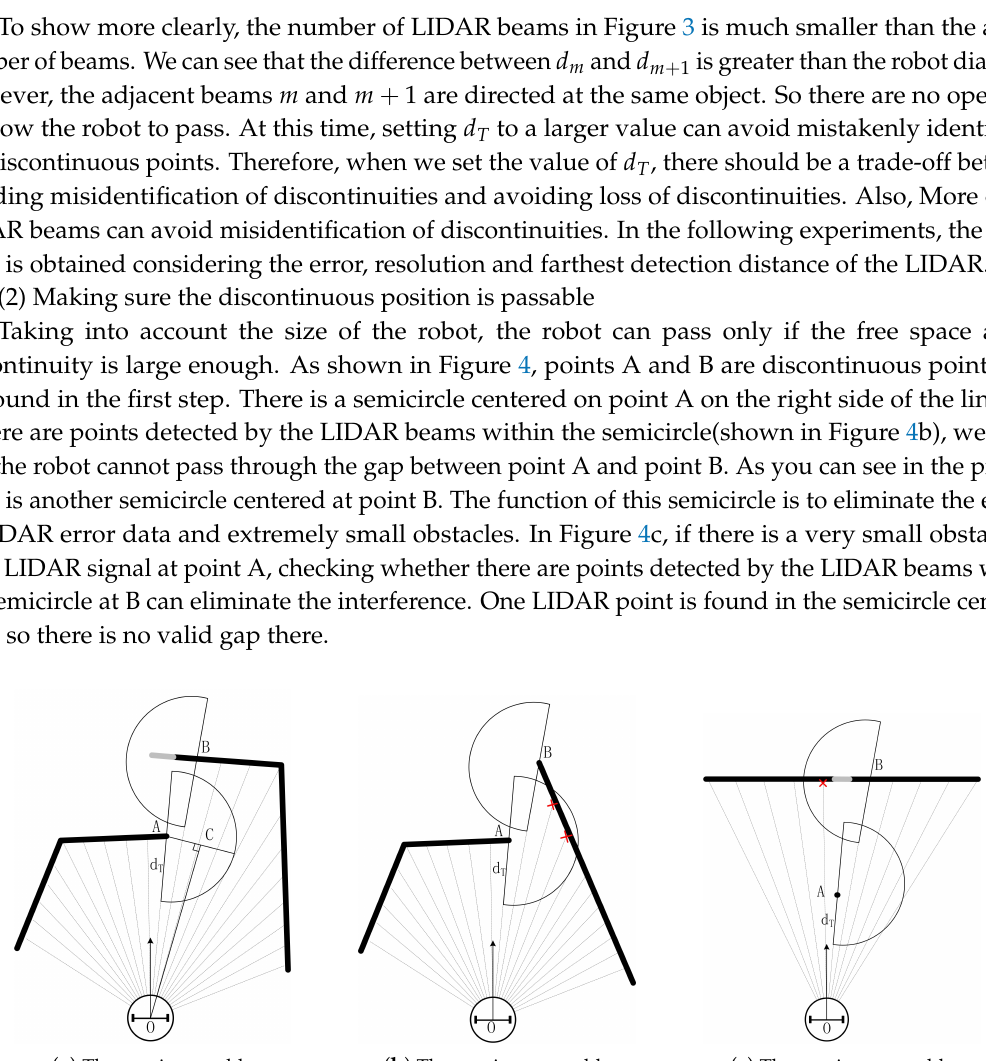
Figure 3. Representation of the LIDAR beams when the robot is near to a wall.